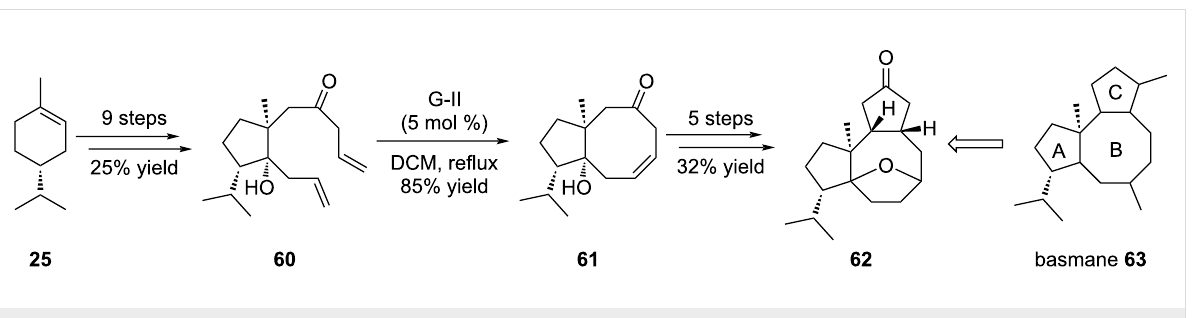
Scheme 10: Synthesis of the core skeleton 63 of the basmane